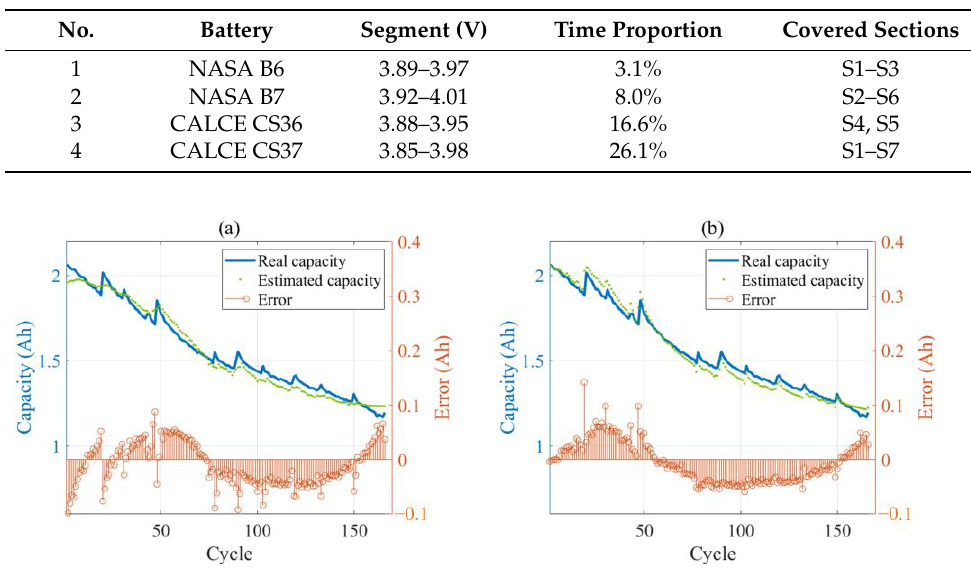
Figure 17. Capacity estimation results of NASA B6 3.89 – 3.97V: ( a ) Case 1; ( b ) Case 2.